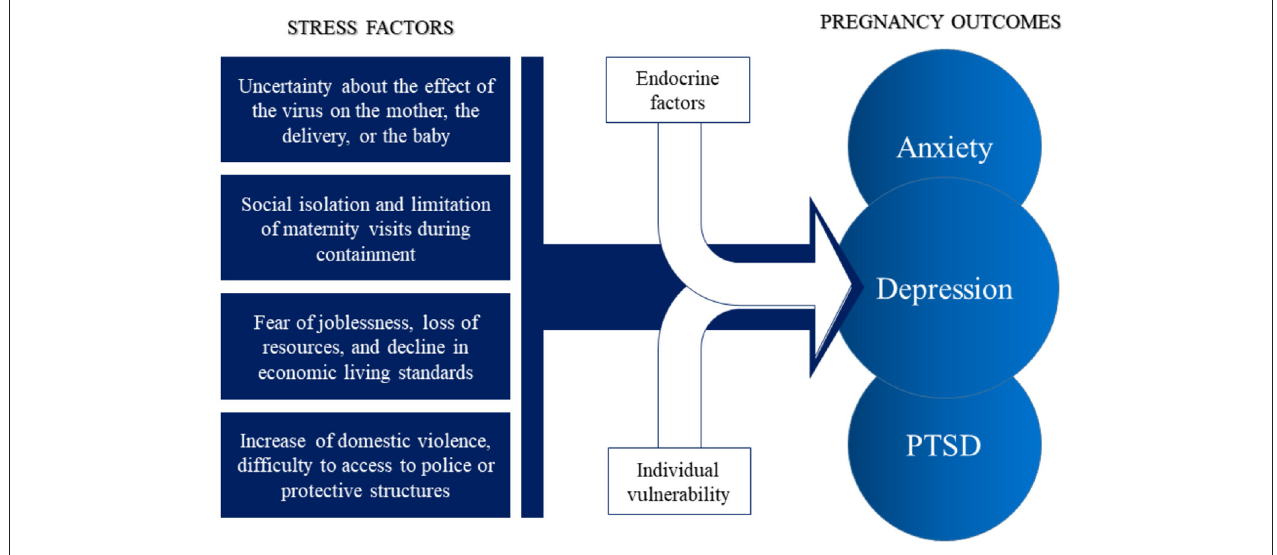
FIGURE 1 | Maternal stress factors and psychiatric outcomes during the COVID-19 pandemic. These stress factors associated with perinatal endocrine factors (variation in cortisol, progesterone, and neurosteroid) and individual vulnerability (domestic violence, social insecurity) may lead to a range of psychiatric symptoms and psychiatric disorder, including anxiety, depression, and post-traumatic stress disorder (PTSD).